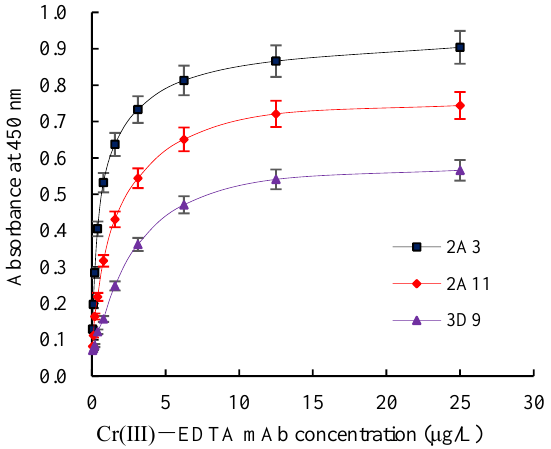
Figure 6. The Ka curves of Cr(III)-EDTA mAbs. Ka: affinity constant.